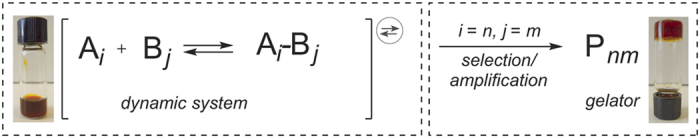
Concept of gelation-driven selection and amplification of organogelator from a thermodynamically controlled dynamic system.A series of substrates Pij is dynamically formed from individual components Aiand Bj, and the dynamic system is subsequently resolved via gel formation of product Pnm.